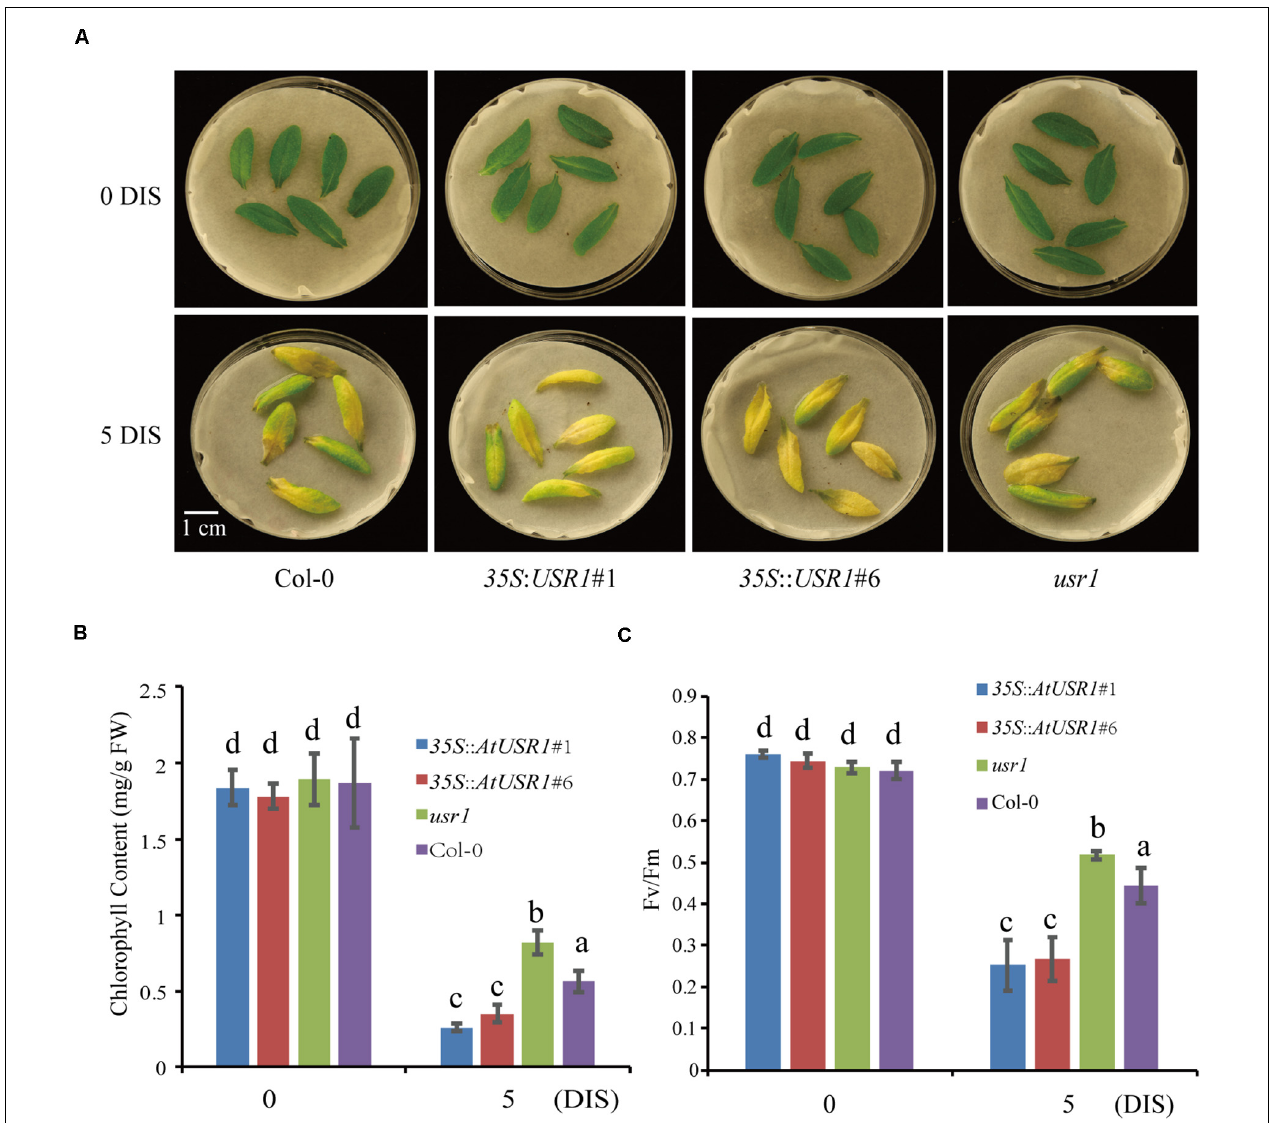
FIGURE 4 | AtUSR1 is involved in dark-induced leaf senescence. (A) AtUSR1 Overexpression lines displayed precocious leaf senescence while the usr1 mutant showed delayed senescence under dark conditions. (B,C) Total chlorophyll content and Fv/Fm of different genotypes as indicated. The data in (B,C) different letters above columns indicate significant differences according to Duncan’s multiple range test ( P < 0.05). Data are shown as the mean ± SD from three independent experiments.